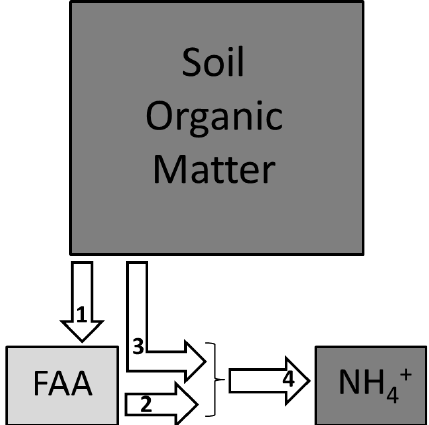
Figure 1. Concept model of investigated N transformations in heathland soil by 15 N tracer techniques: (1) free amino acid (FAA) production ( 15 N–AA pool dilution), (2) FAA mineralization ( 15 N– NH + production from 15 N–AA, 15 N-tracing), (3) mineralization 4 from other soil organic matter (not measured directly), and (4) gross N mineralization ( 15 N–NH + pool 4